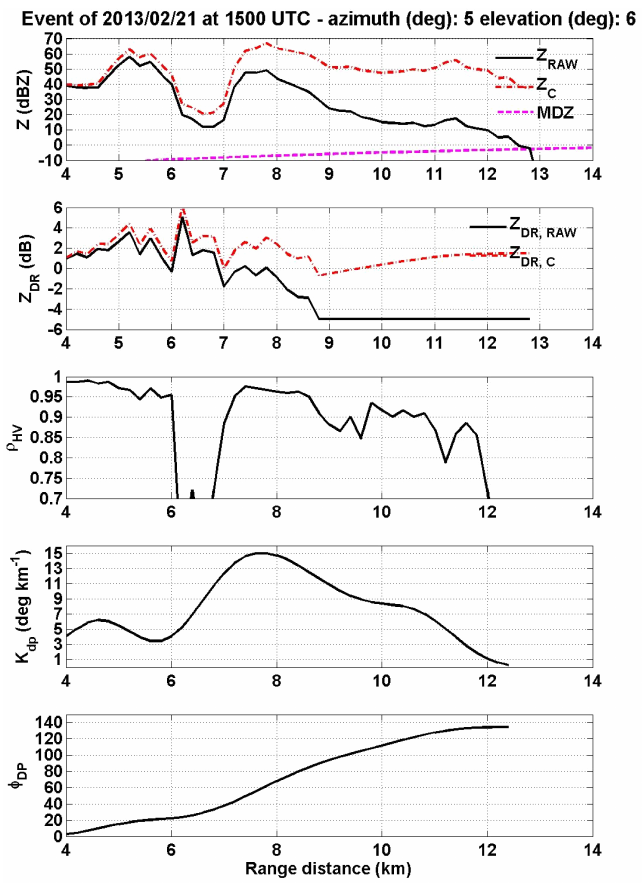
Figure 7. Range plots of the polarimetric radar parameters Z H , Z DR , ρ HV , K DP and (cid:56) DP taken at 5 ◦ of azimuth and 6 ◦ of antenna elevation on 21 February 2013 at 15:00UTC. The two upper panels also show the attenuation-corrected reflectivity and differential reflectivity. The minimum detectable Z H (MDZ) is also plotted on the upper panel.